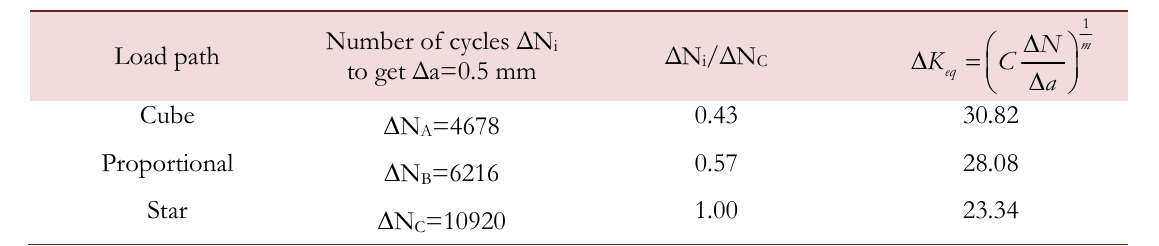
Table 1: Number of cycles required to grow the crack by fatigue by  a=0.5 mm in each experiment, equivalent stress intensity factor   K MPa m  required to get a growth rate eq